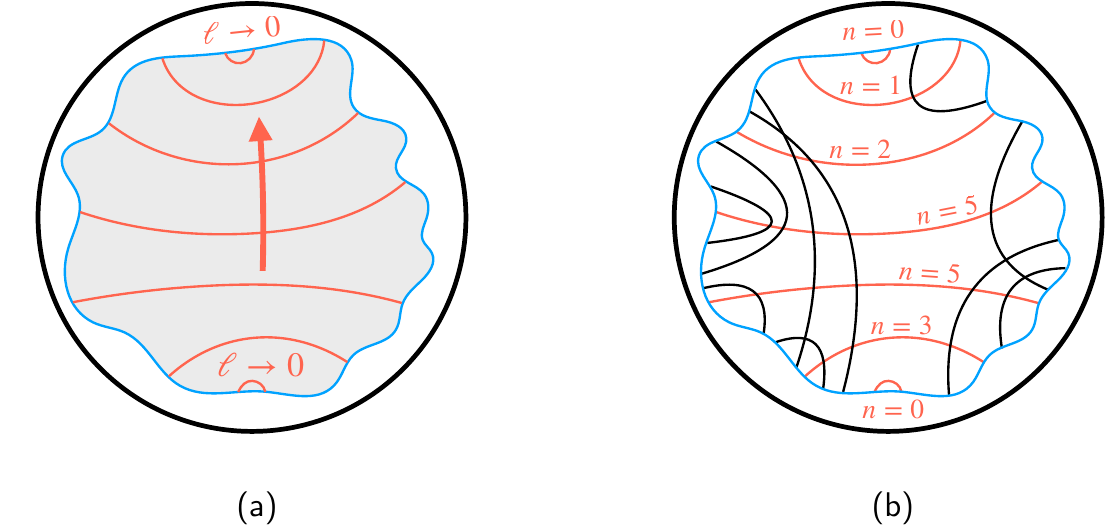
Figure 2 . (a) The Hilbert space of JT gravity with no matter. The dynamical degree of freedom is the length ‘ between the two sides (pink curves). The disk partition function is obtained by imposing ‘ = 0 boundary conditions in the Euclidean past and future. (b) The Hilbert space of double scaled SYK with no matter insertions. The dynamical variable is n , the number of chords. In the microscopic description qn is just the size of the density matrix. We have drawn the chords so that for any red curve, the chords which intersect that curve cross do not cross in the Euclidean